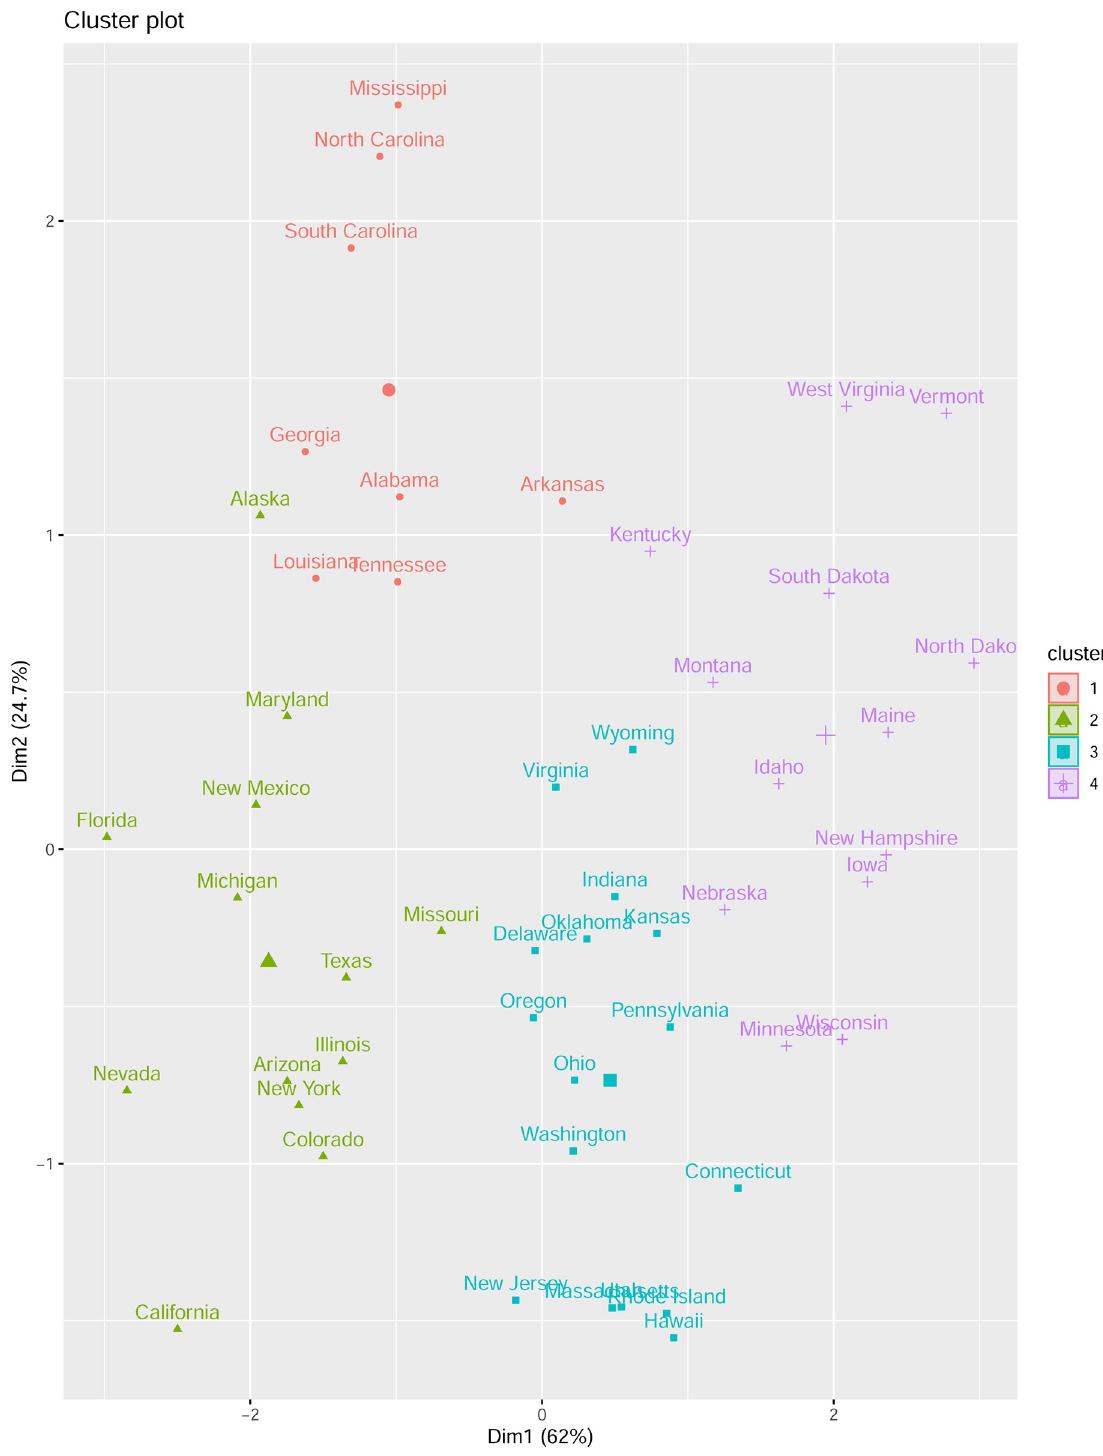
Fig 10. US arrests clusterings from the hierarchical k -means algorithm and the gap method.